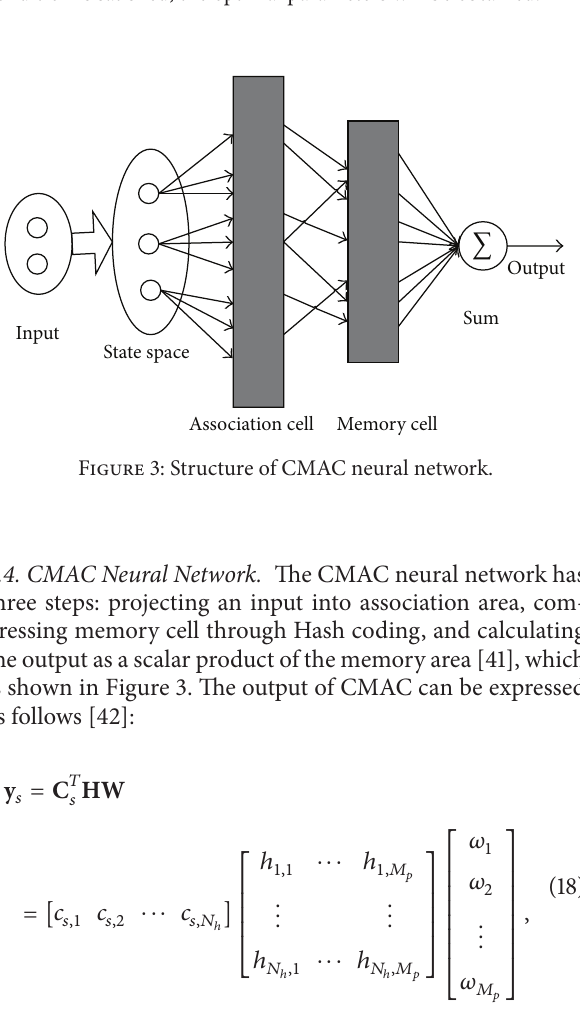
Figure 2: The process of GA optimization, when the convergence condition is satisfied, the optimal parameters will be obtained.